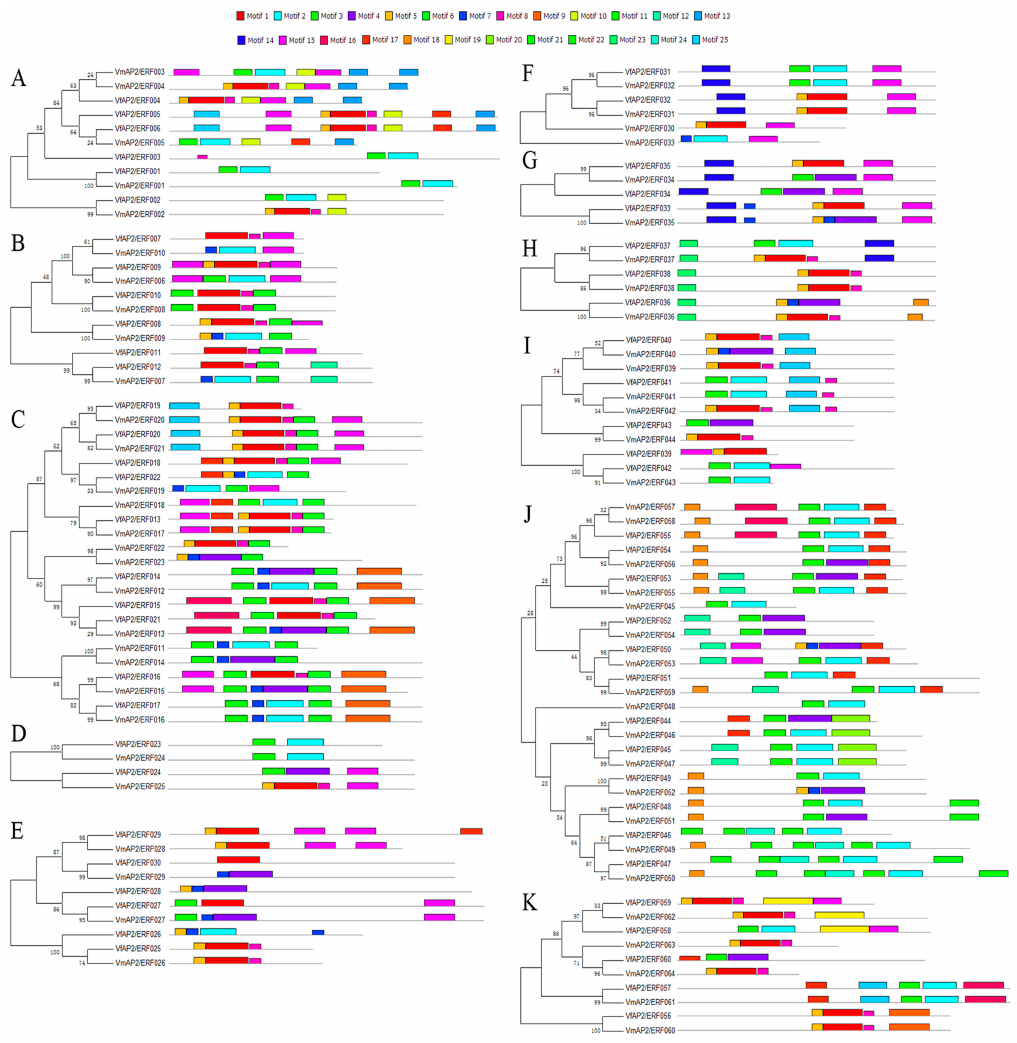
Figure 2. Phylogenetic relationships ( left ) and distribution of conserved motifs ( right ) among the V. fordii and V. montana ERF proteins from groups I ( A ); II ( B ); III ( C ); IV ( D ); V ( E ); VI ( F ); VI-L ( G ); VII ( H ); VIII ( I ); IX ( J ); and X ( K ). The phylogenetic tree was generated using MEGA5. The motifs (1–25) were identified by MEME, and different motifs are indicated by different colors.